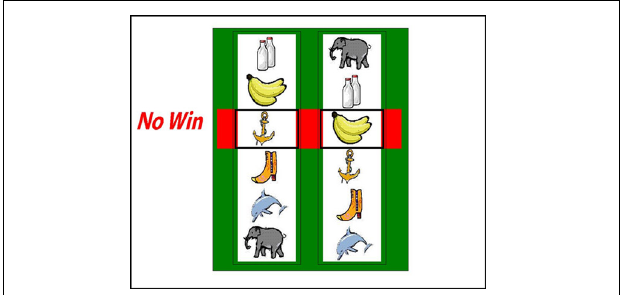
FIGURE 1 | The slot machine task displayed two reels, with the same six icons on each reel. Each trial involved a fixed £0.15 p wager. After a selection phase in which either the computer or the participant chose one of the icons on the left reel as the “play icon,” the right reel spun for a variable anticipation phase. The right reel decelerated and came to a standstill. If the right reel stopped on the chosen play icon, i.e., the reels were aligned on the central payline, the subject won £1. If the right reel stopped on a different icon (5/6 trials), the participant lost their wager. In the analysis of these non-wins, we distinguished near-misses (with the play icon either side of the payline) and full-misses (with the play icon more than one position from the